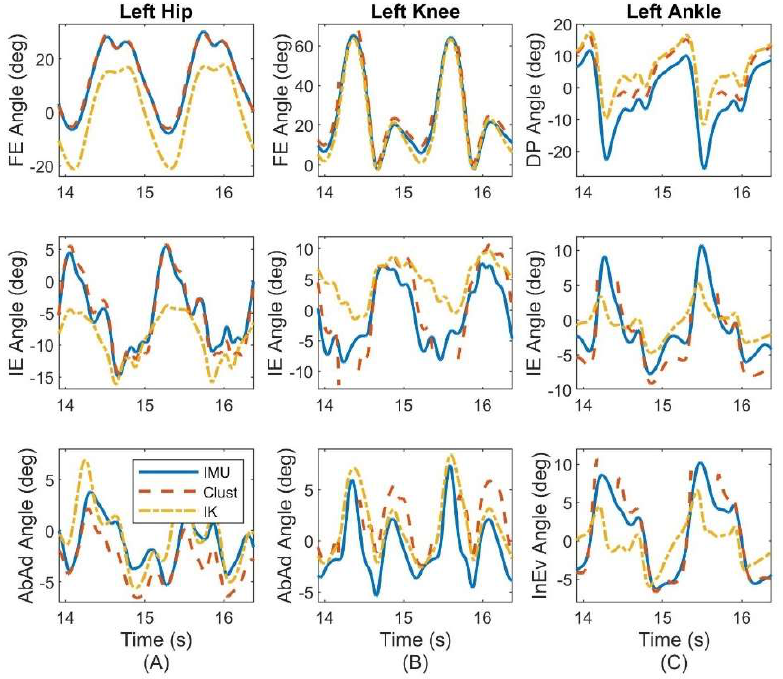
Figure A1. Normal Walking. Example joint angle estimates over two stride cycles for normal treadmill walking. Plots show the three anatomical angles for ( A ) left hip, ( B ) left knee, and ( C ) left ankle. Estimates are also compared between ErKF (IMU), cluster (Clust), and inverse kinematics (IK) methods.